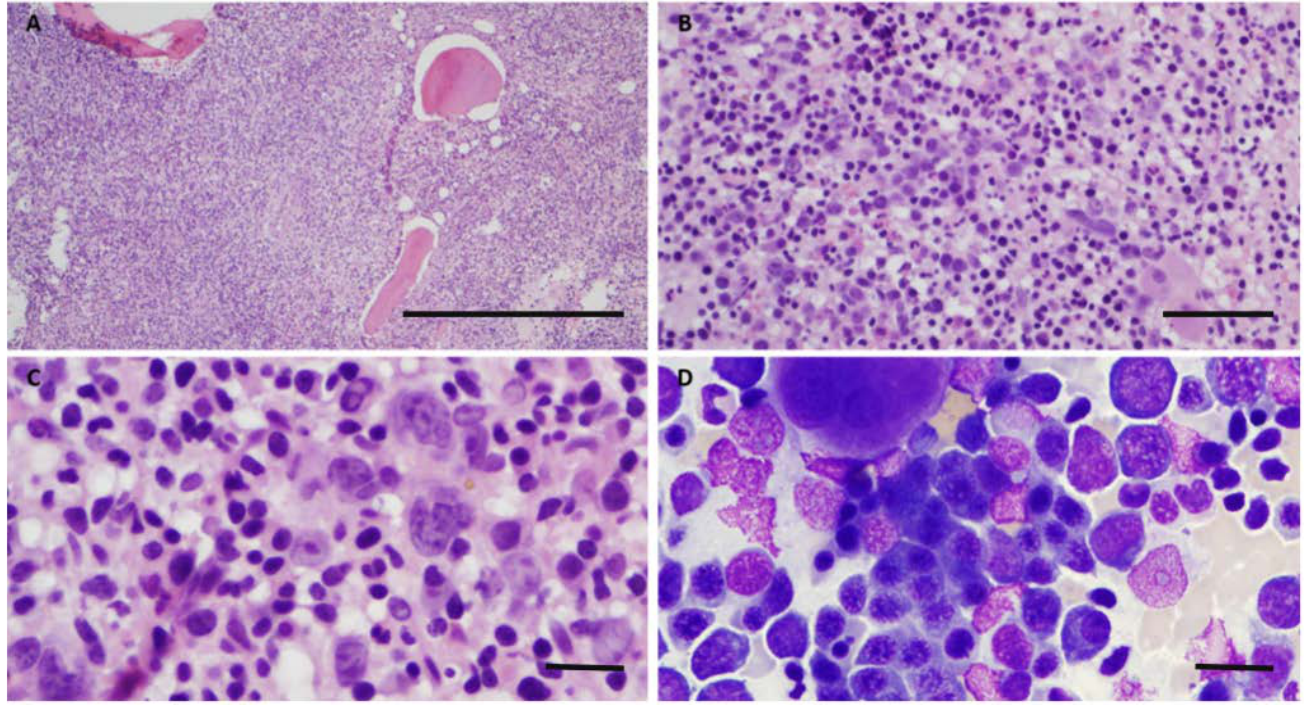
Figure 1. Initial diagnostic bone marrow biopsy and aspirate. The marrow is markedly hypercellular with diffuse lymphoid infiltrates consisting of predominant small lymphocytes, plasmacytic lymphocytes and rare plasma cells (H&E at 20× and 400×, respectively, in ( A ) and ( B )). In the background, there is maturing trilineage hematopoiesis with dysmegakaryopoiesis and few blasts (( C ). H and E at 1000×) and erythroid hyperplasia with dysplasia (( D ) Wright-Giemsa stained aspirate at 1000×). (Scale bars = 2 mm in magnification at 20×, 50 µm at 400×, and 25 µm at magnification 1000×). Cytogenetic analysis demonstrated a normal 46XY karyotype. PCR was negative for JAK-2 (V617F and exons 12/13), MPL (W515 AND S505), CAL-R , MYD88 , CXCR-4